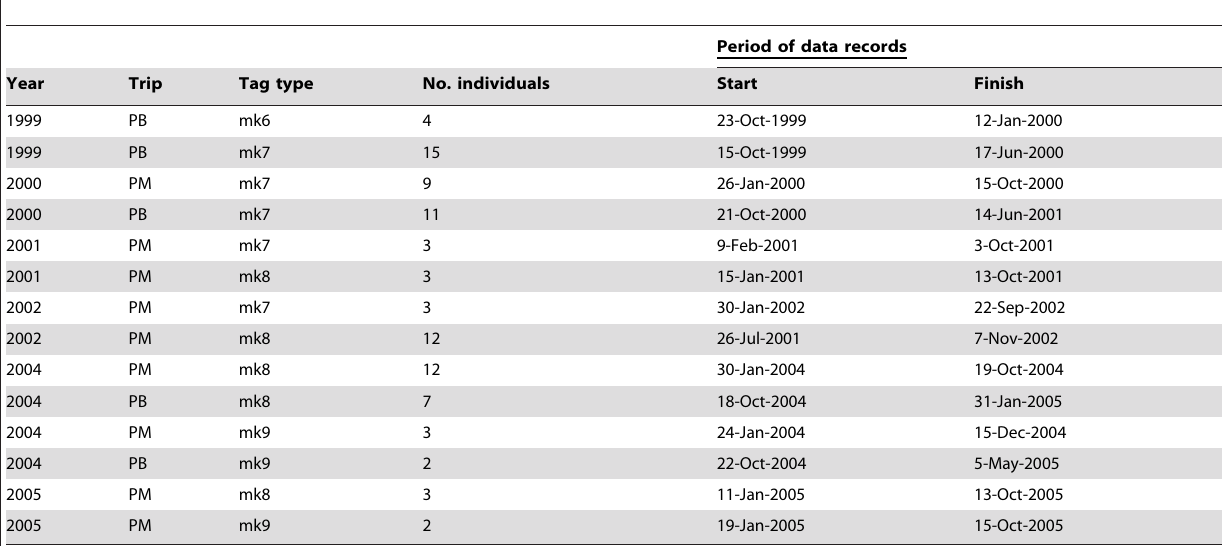
Table 1. Summary of tag deployments for 89 female elephant seals: year, trip, tag type used, number of individuals tagged, and period of data records (start to finish